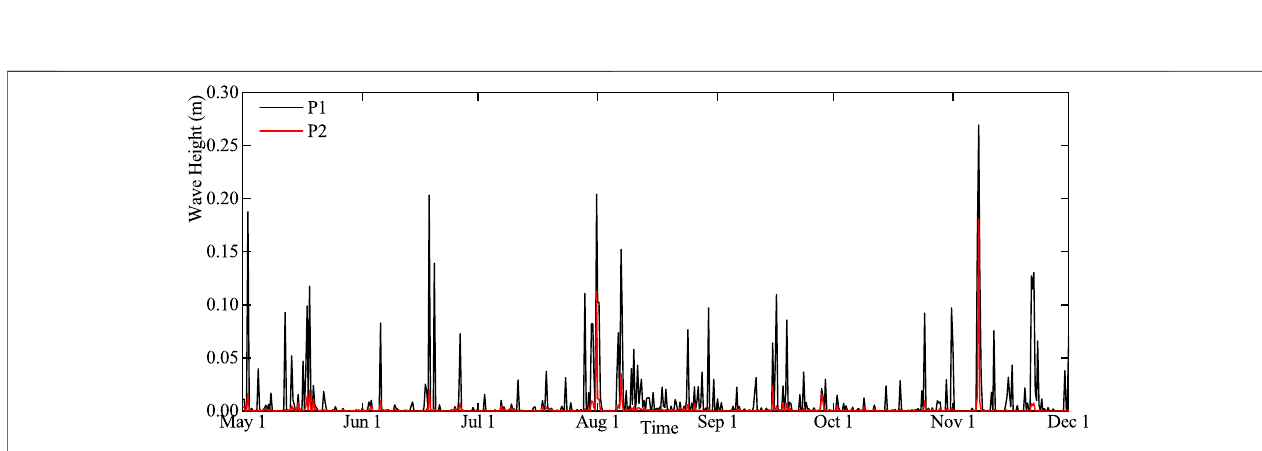
FIGURE 12 | Time variation of wave height difference at monitoring points; positive values in the fi gure indicate that the wave height under the condition of without vegetation is higher than that under the condition of with vegetation.